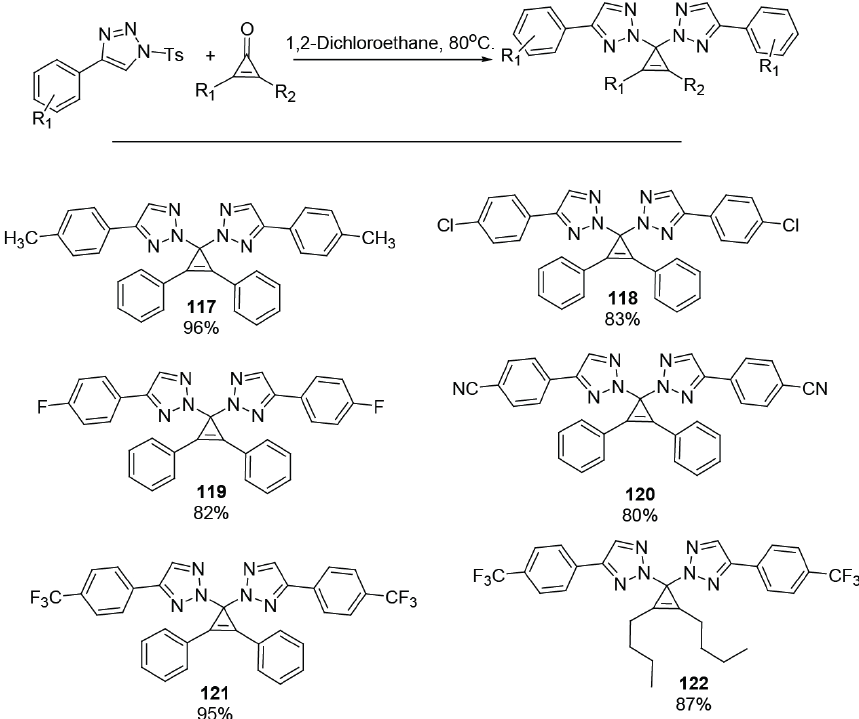
Figure 18 - N 2 -regioselective autocatalytic ditriazolylation reaction of cyclopropenones with N 1-